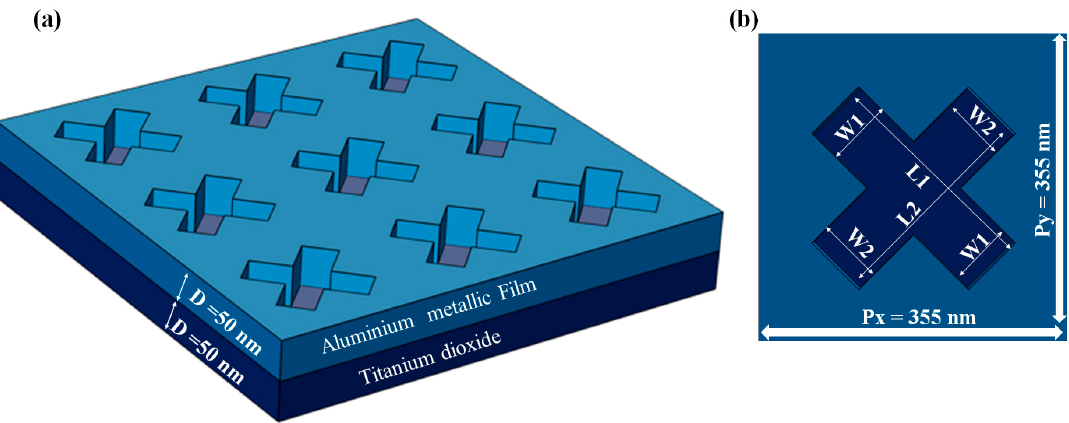
Figure 1. ( a ) EOT PCFs X-shaped nanostructure array; ( b ) a schematic illustration of the X-shaped structure of a single pixel. The filter’s substrate is TiO2, and an aluminum film is deposited on top of it.